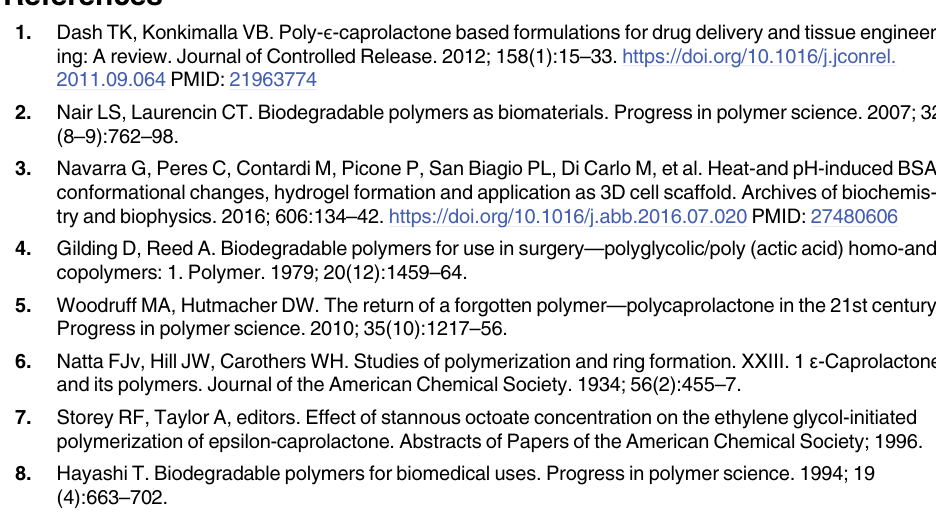
S2 Fig. Cellular morphological analysis. Representative morphological images of HDFa cells